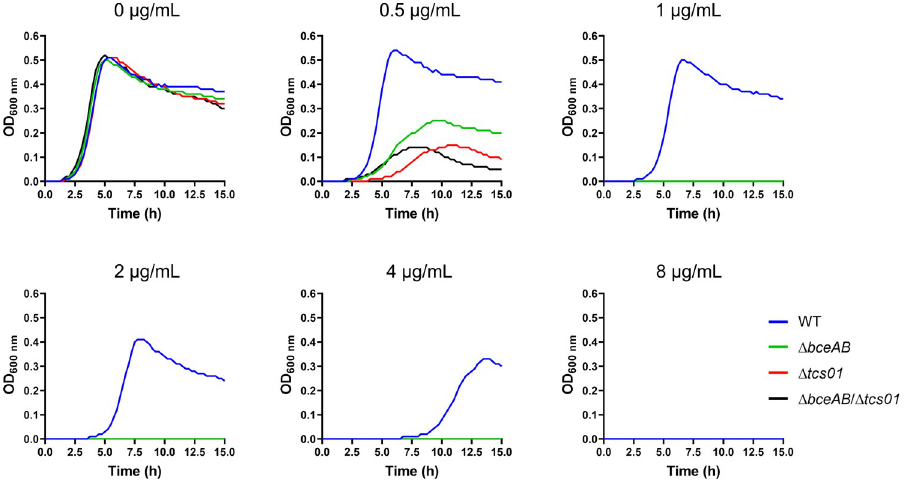
Fig 1. Growth of wild-type and mutant strains in the absence or presence of various concentrations of bacitracin. The bacitracin concentrations are indicated on top of the graphs. Cultures were performed in microplates. This representative experiment of 4 biological replicates shows the average of technical duplicates grown in a 96-well microplate.